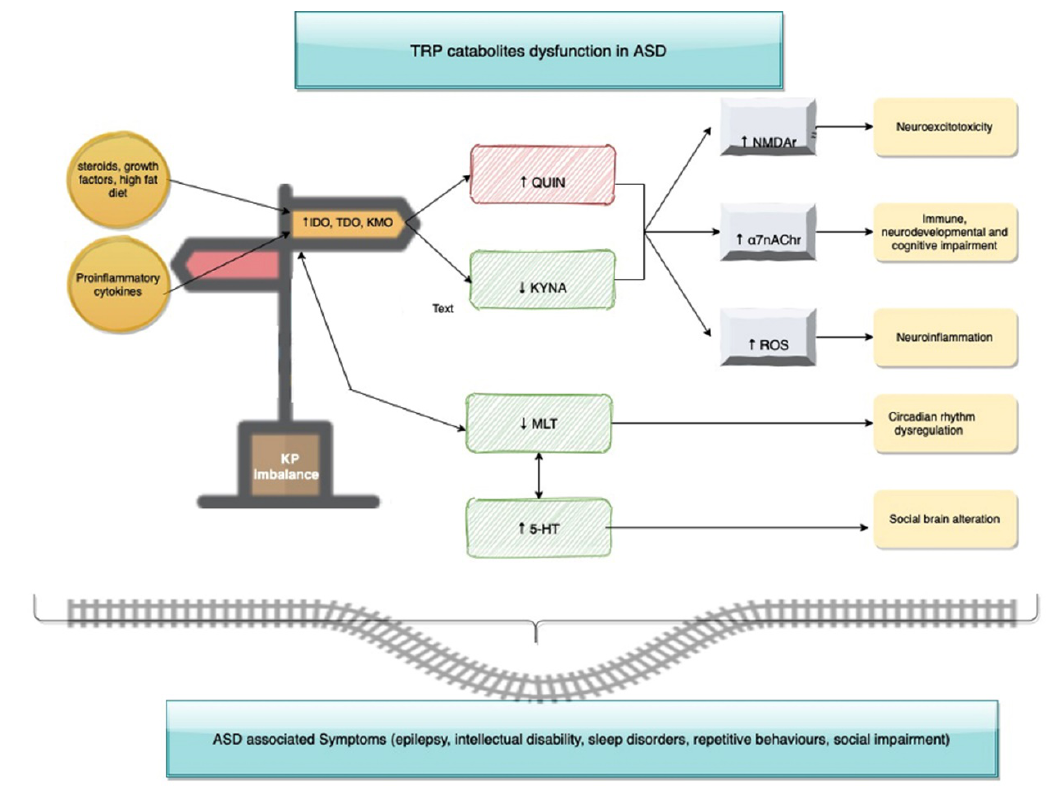
Figure 3. Kynurenine (KP) as a crossroad between disrupted routes and pathophysiological conditions that are Autism Spectrum Disorder (ASD) related.